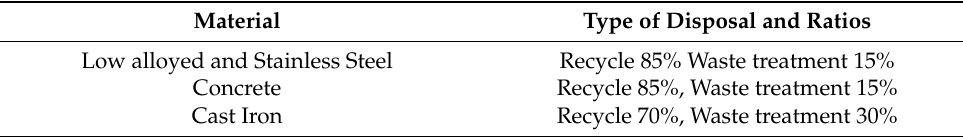
Table 4. Assumptions for End-of-Life (EoL) scenarios.